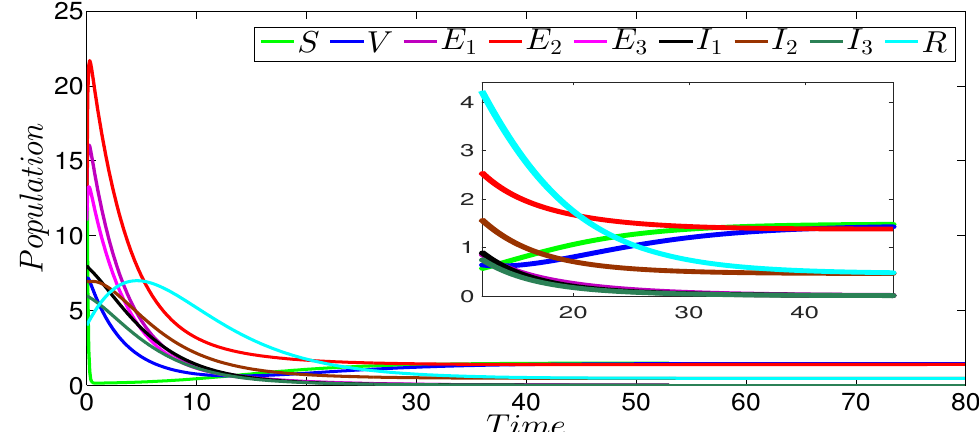
Figure 4. Stability of the strain-2 endemic equilibrium E s = 0.55, R 2 = 1.93, and R 3 R 1 0 0